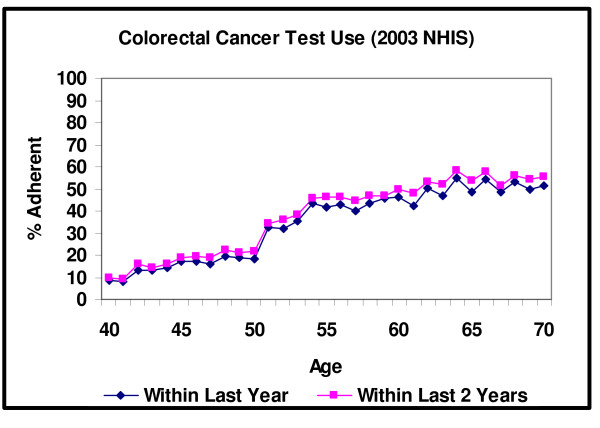
Colorectal Cancer Test Use within the Last 1 and 2 years. Note: An individual is adherent with the colorectal cancer guidelines within the last year if they received either an FOBT within the last 1 year, a sigmoidoscopy within the last 5 years or a colonoscopy within the last 10 years. Adherence within the last 2 years is defined in a similar manner except individuals may receive an FOBT within either the last 1 or 2 years.